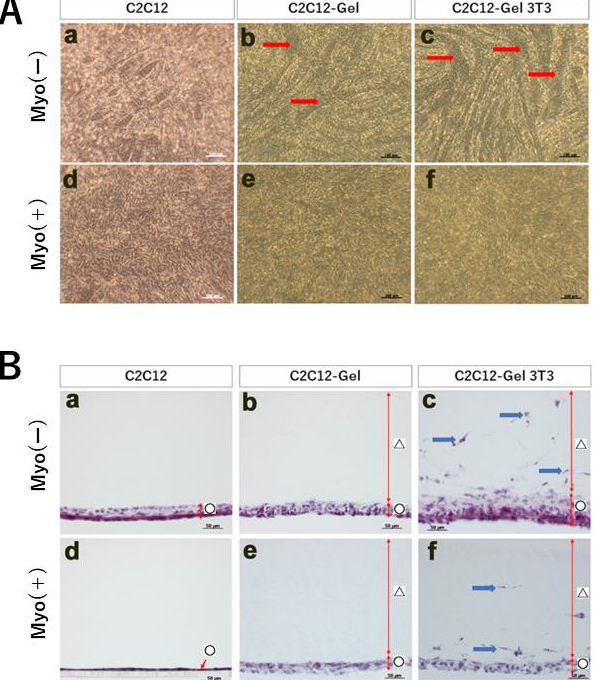
Figure 3. Preparation of the pseudo MTJ model after 1 week of culture (Part 1). ( Panel A ) Morpho- logical observation of laminated sheets. Three types of cell sheets (C2C12, C2C12-Gel, and C2C12-Gel 3T3) were cultured without Myo( − ) and with myostatin Myo(+), resulting in A: Observation in a bright field. Compared to C2C12 ( a ), myotube structures are observed in C2C12-Gel ( b ) and C2C12- Gel 3T3 ( c ) (red arrows). In Myo(+), no myotube-like structure was observed in any type of cell sheet ( d – f ); ( Panel B ) Hematoxylin–eosin staining of frozen thin sections. In comparison to C2C12 ( a ) and C2C12-Gel ( b ), cell sheets are thicker in C2C12-Gel 3T3 ( c ). Addition of Myo did not increase the thickness of any type of sheet ( d – f